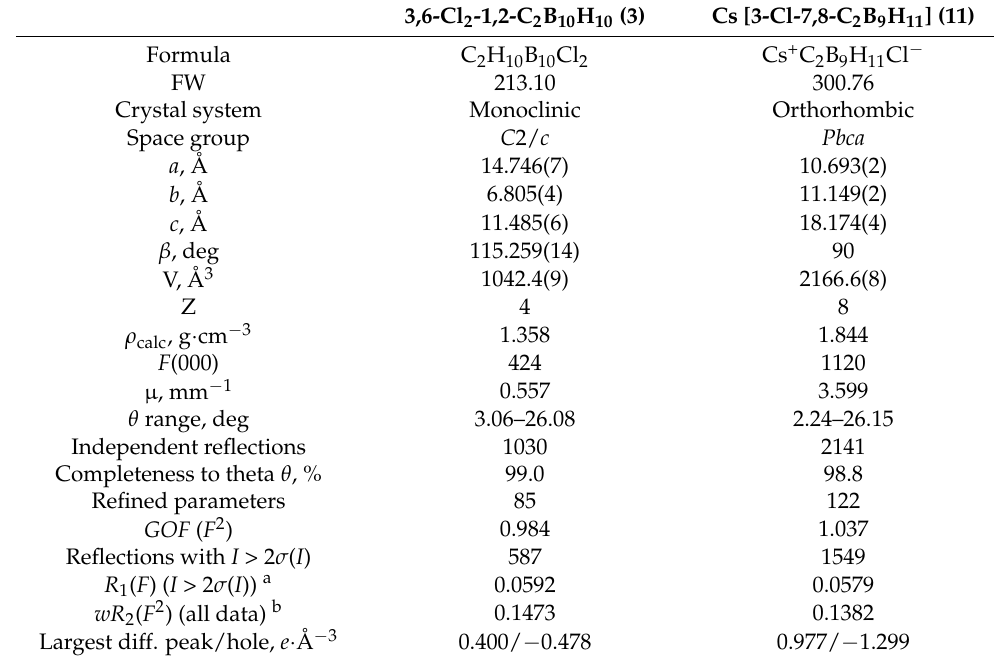
Table 1. Crystallographic data for compounds 3,6-Cl 2 -1,2-C 2 B 10 H 10 ( 3 ) and Cs [3-Cl-7,8-C 2 B 9 H 11 ] ( 11